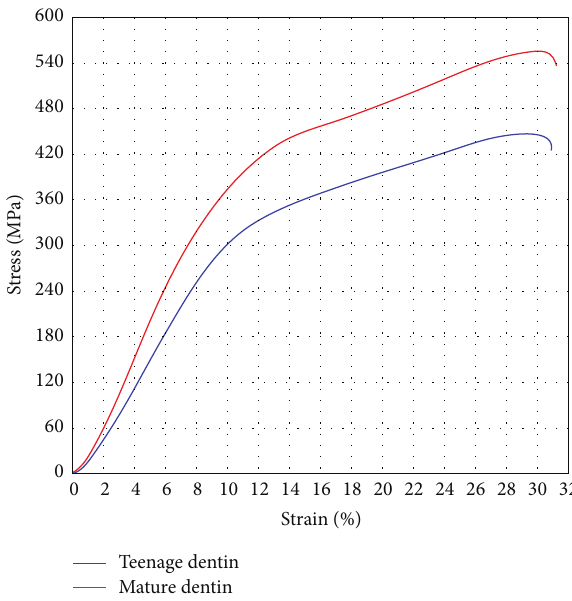
Figure5:Typicalstress-straincurvesundercompression:redcurve, teenage dentin; blue curve, mature dentin. Compression strength of teenage dentin is less on about 20% than mature dentin, while their total deformation is the